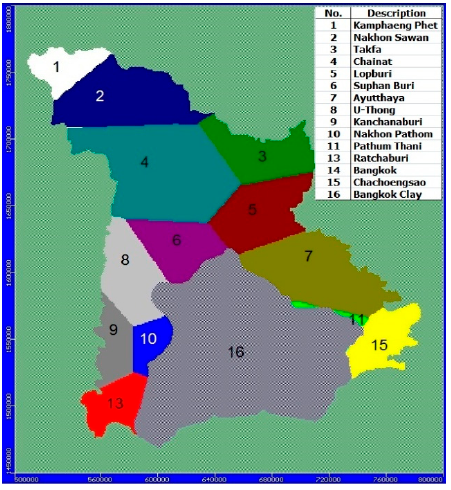
Figure 7. The recharge area using the Thiessen polygon rainfall distribution in the study area.